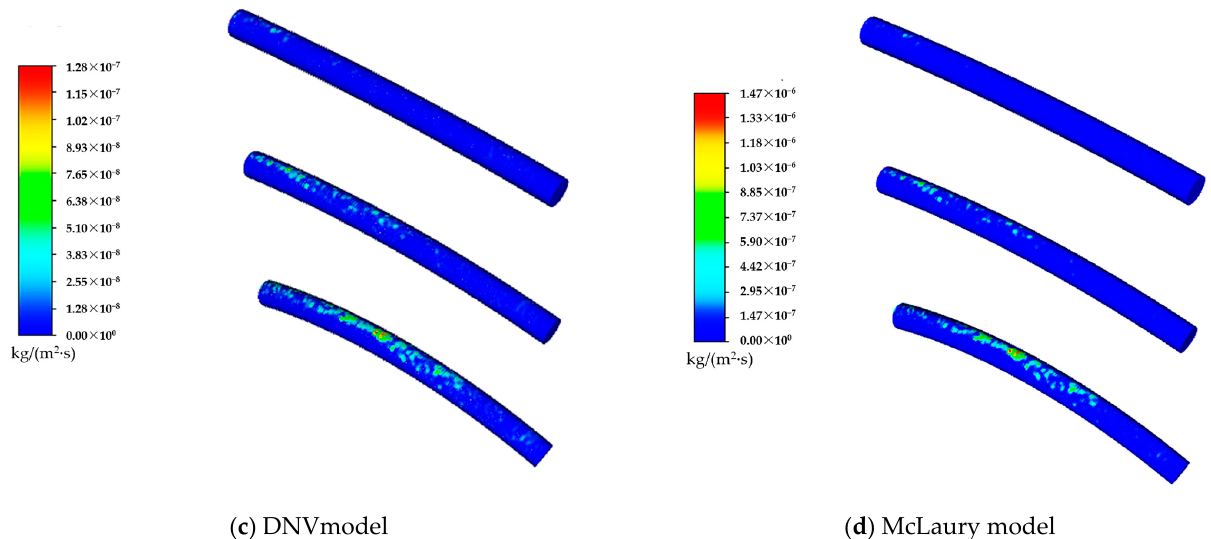
Figure 8. Erosion clouds under different erosion models.